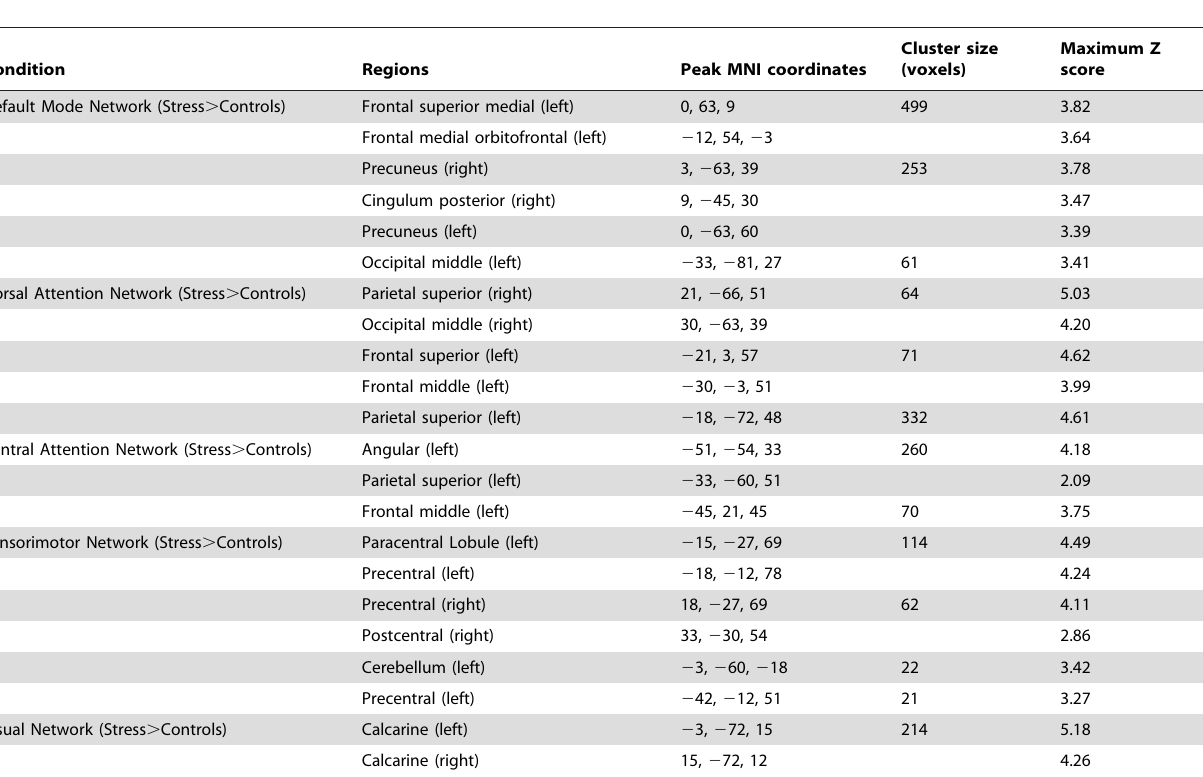
Table 1. Group Differences (Stress . Control) at rest, in brain regions of the DMN, DAN, VAN, SMN and VN maps (two sample t- tests, corrected for multiple comparisons, p , 0.05).